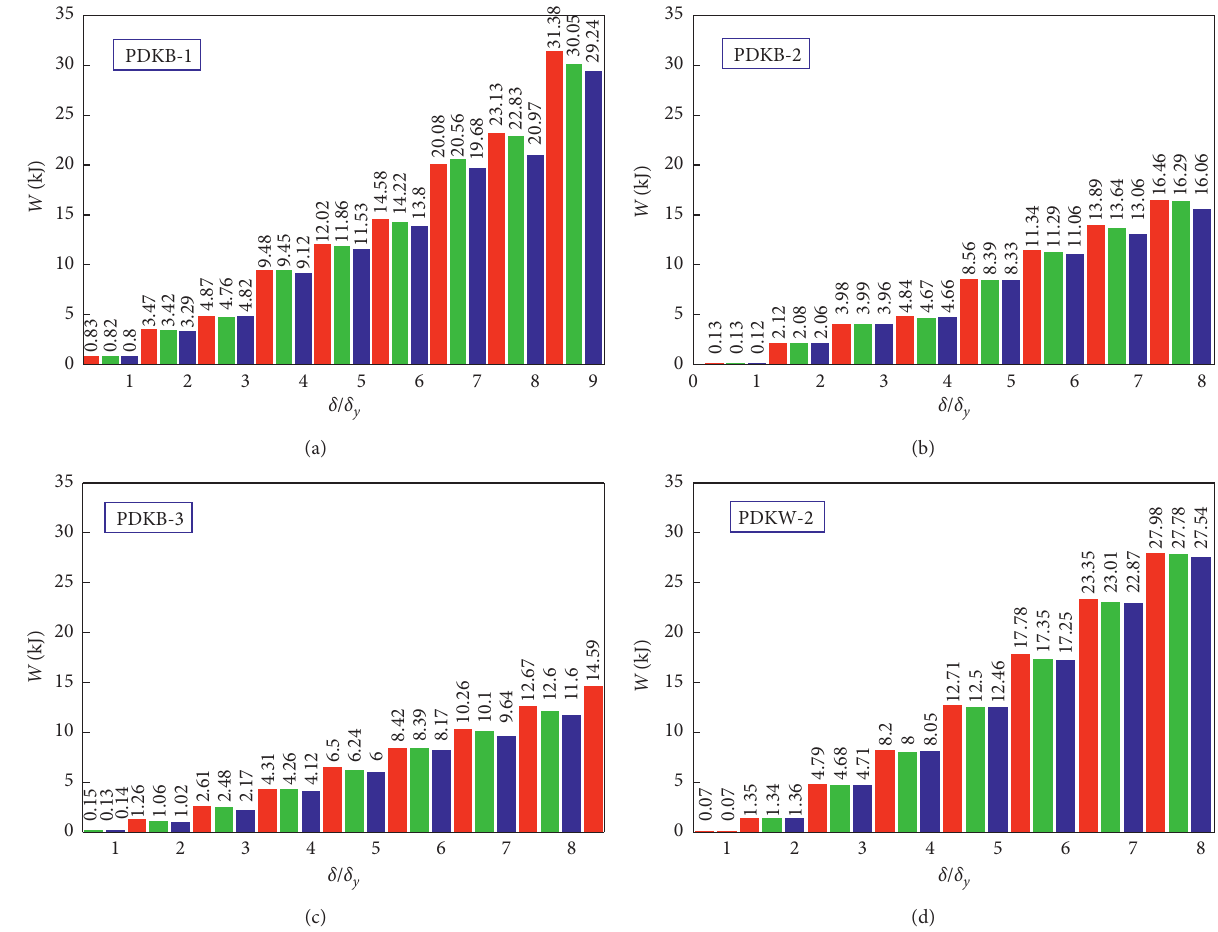
Figure 22: Energy dissipation of the hysteretic loop in test specimens.